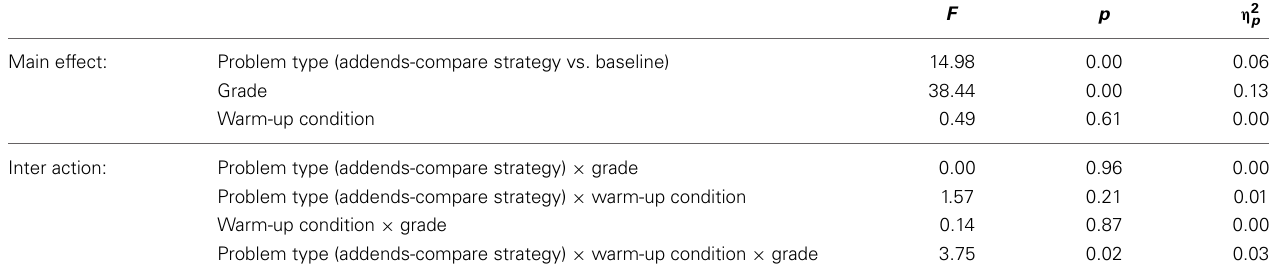
Table 4 | Experiment 2: Results of the ANOVA problem type × grade × condition.